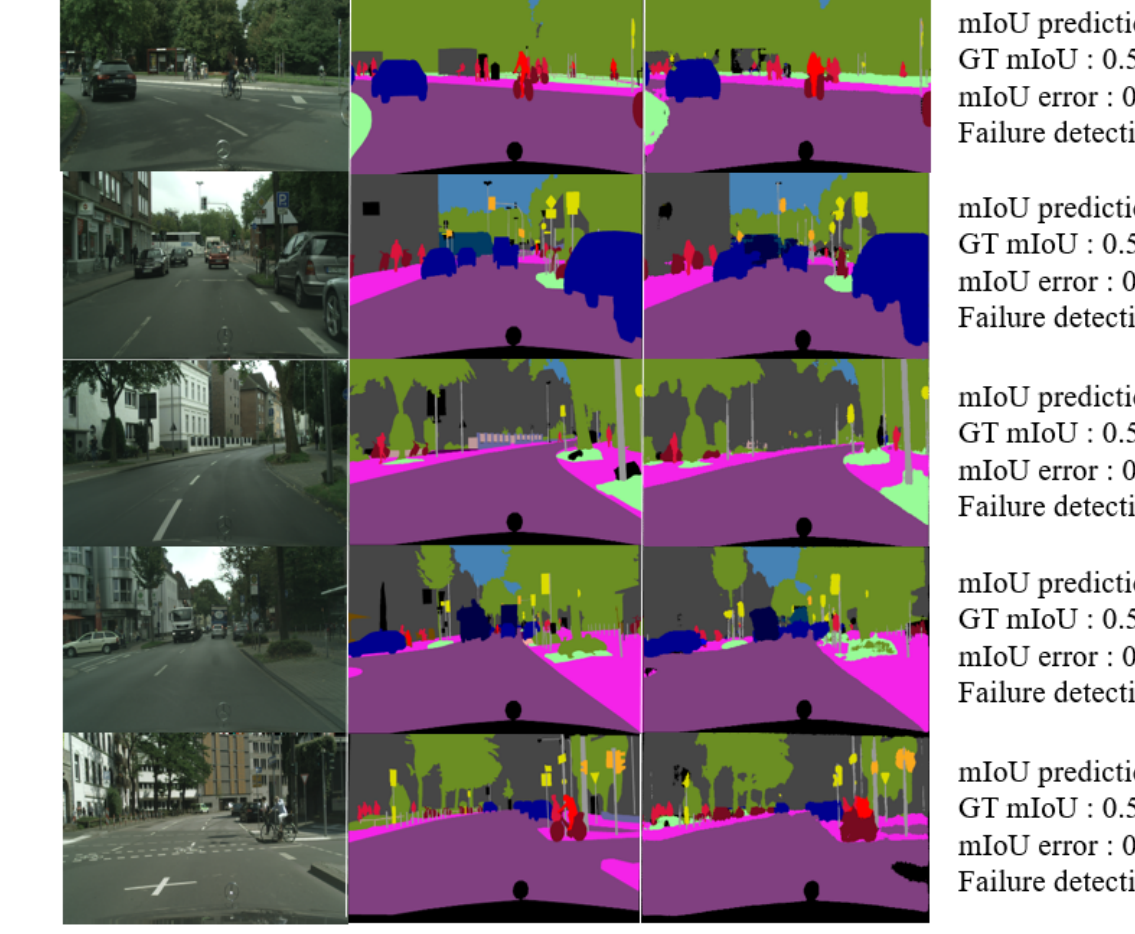
Figure 10. Examples of false-negative images in the Cityscapes